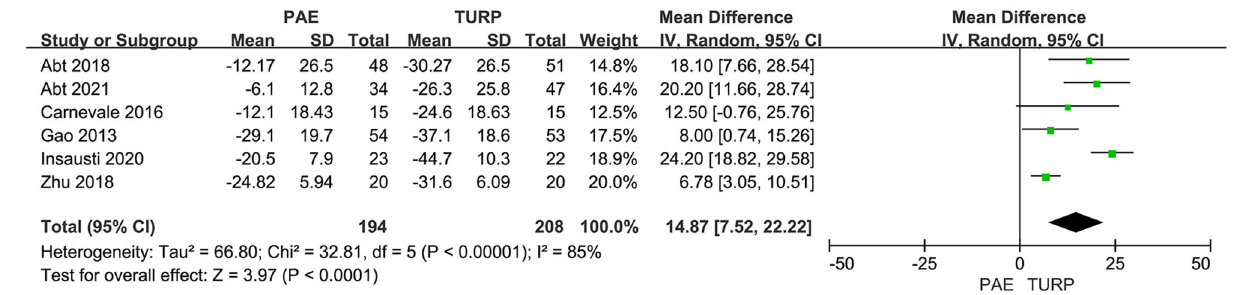
FIGURE 5 | Forest plot for PV. PV, prostate volume.